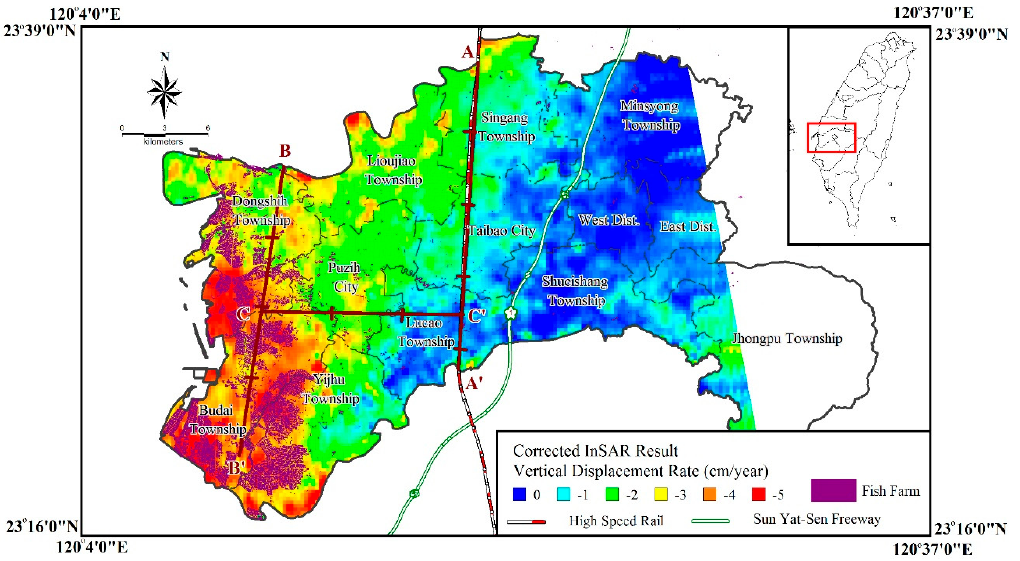
Figure 12. The merged (corrected InSAR) field of vertical displacement rates obtained by correcting the InSAR result by the precision leveling result. Notable subsidence occurs along the coasts covered by fish farm. The rates along profiles A-A’, B-B’ and C-C’ are used in Figure